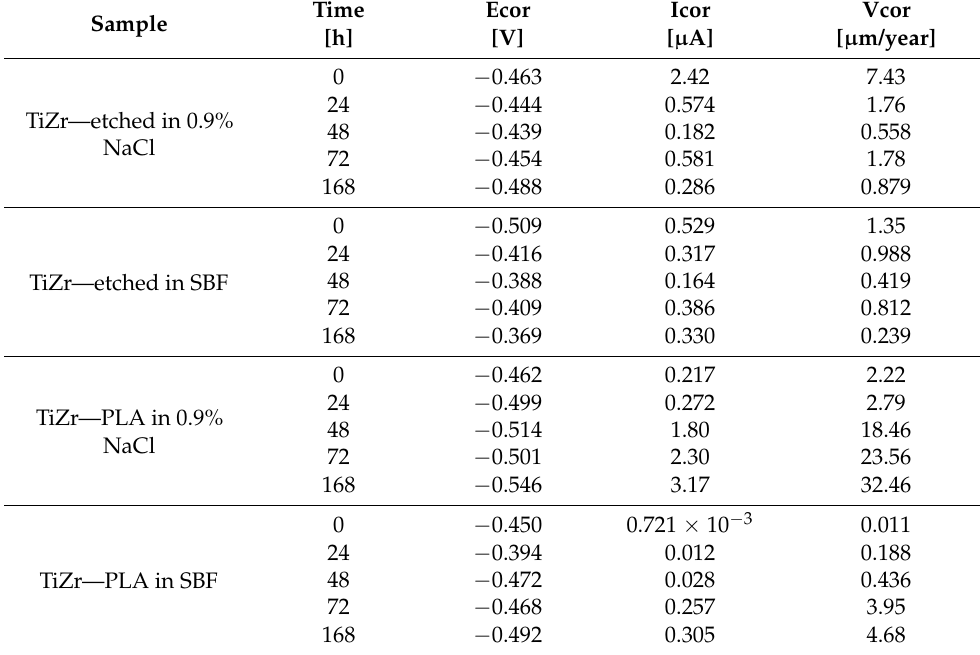
Table 5. Electrochemical parameters of potentiodynamic polarization curves of the different